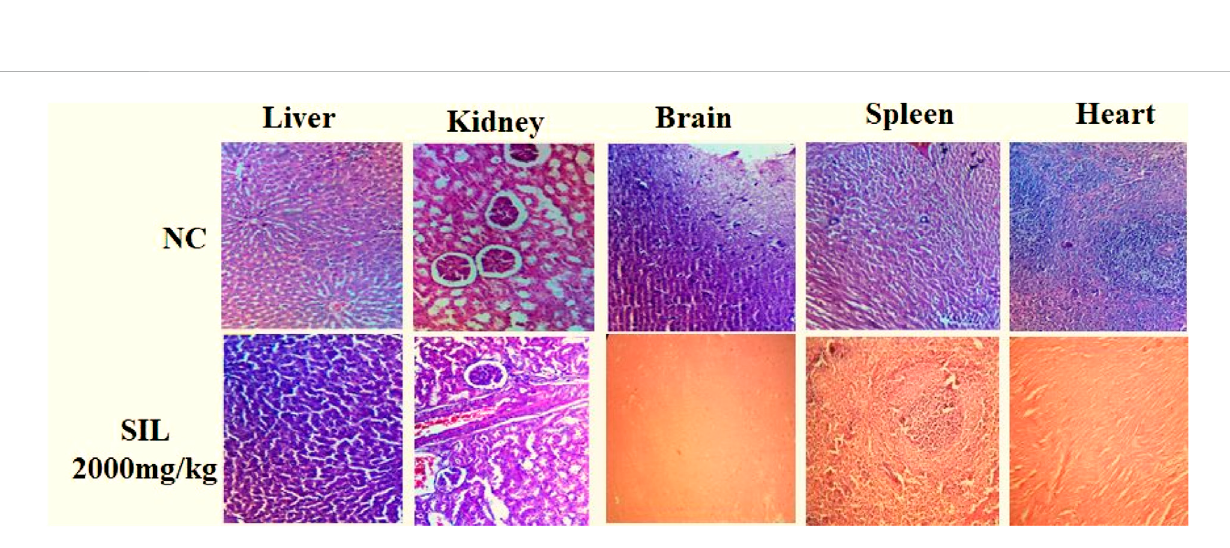
EffectofnormalcontrolandSILtreatmentonoxidativestressmarkers.Datapresentedasmean±SEM.n=6.Here,*** p < 0.001highsigni fi cantincrease vs. the control group, and *** p < 0.001 signi fi cant decrease compared with the normal control group.